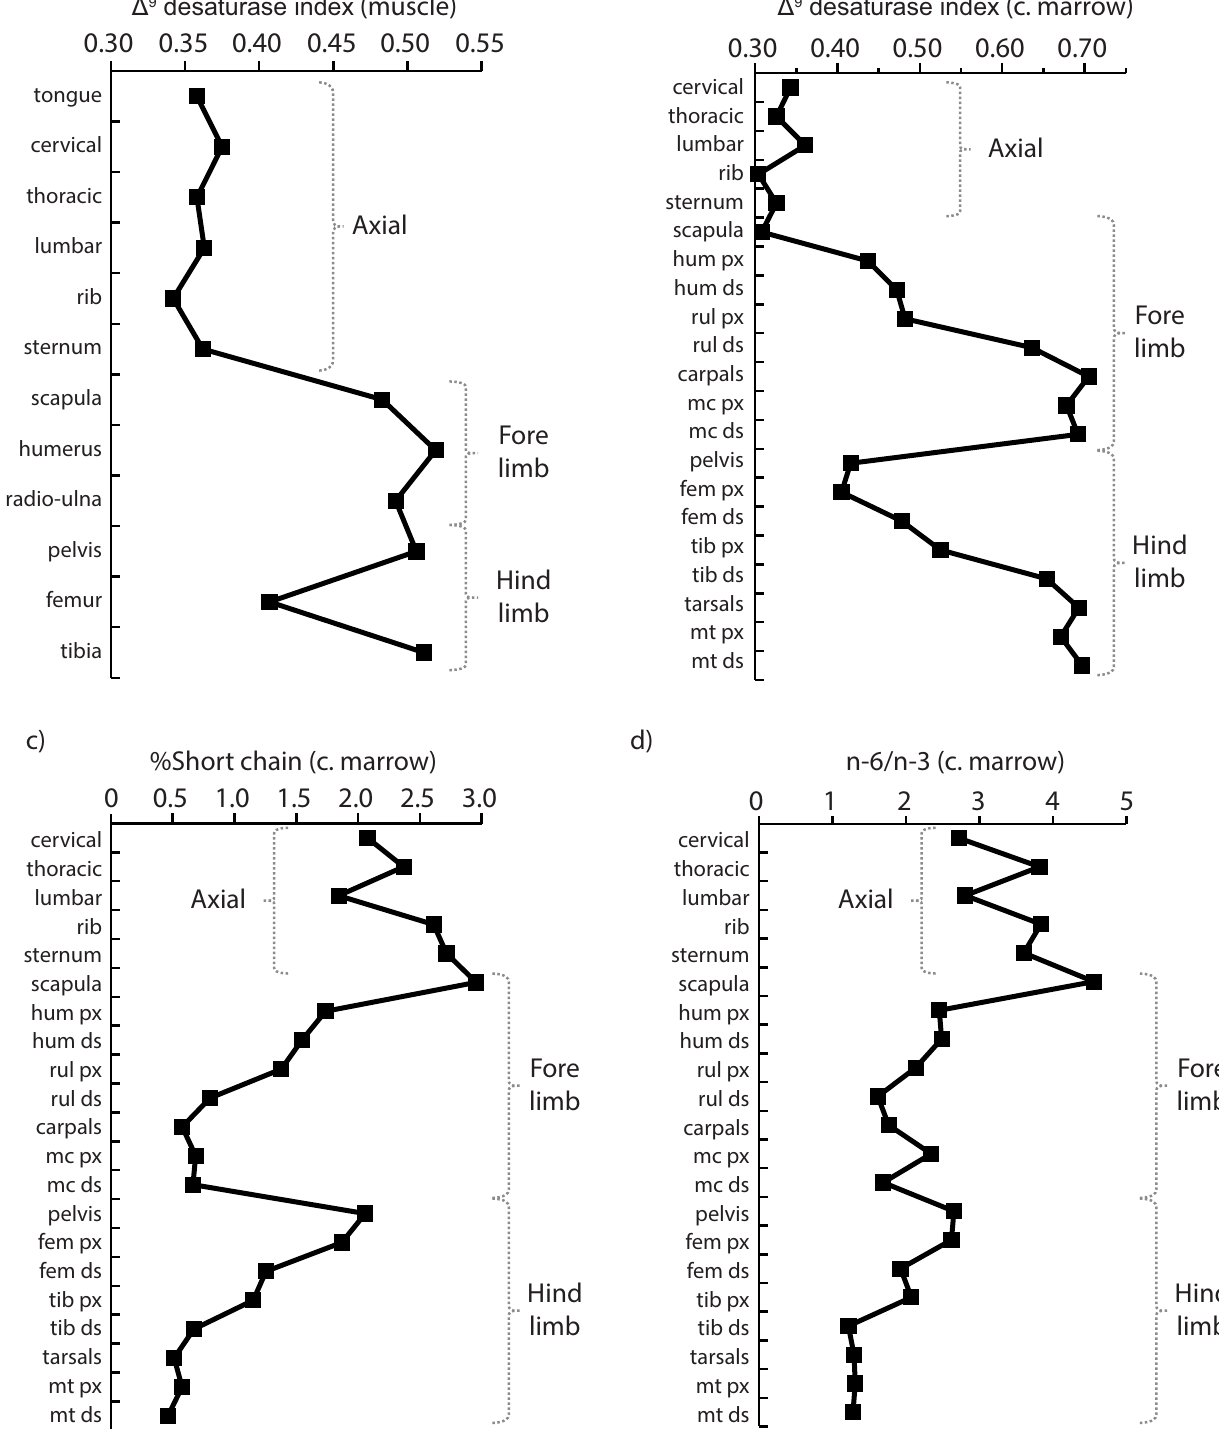
Fig 6. Fatty acids (FA) in the axial and appendicular skeleton of caribou. a) Δ 9 desaturase index in muscle tissues; b) Δ 9 desaturase index in cancellous marrow; c) percentage of short chain saturated FA in cancellous marrow; d) n-6/n-3 ratio in cancellous marrow. Comparisons for marrow exclude the shaft cavities. The data points correspond to the mean for the two animals. Data from Tables 2, 3 and (S1 File). Abbreviations: c. marrow = cancellous marrow; hum = humerus; rul = radio-ulna; mc = metacarpal; fem = femur; tib = tibia; mt = metatarsal; px = proximal epiphysis; ds = distal